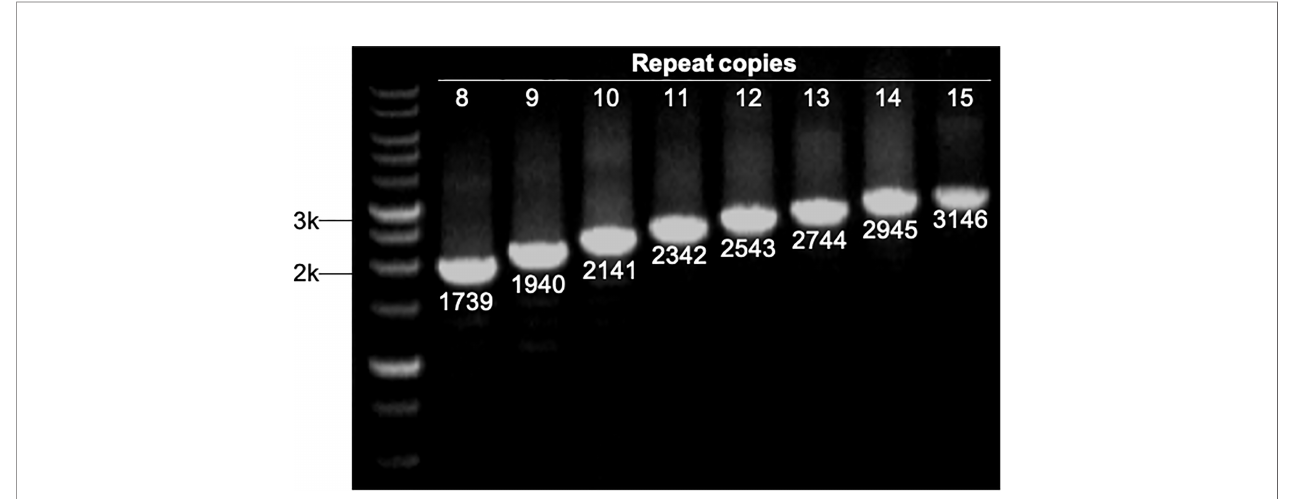
FIGURE 1 | Strains with different repeat copies were examined by PCR. All PCR products were sequenced to determine their sizes, which represented different repeat copies ranged from 1739 bp (8 copies) to 3146 bp (15 copies). M represents 1 kb